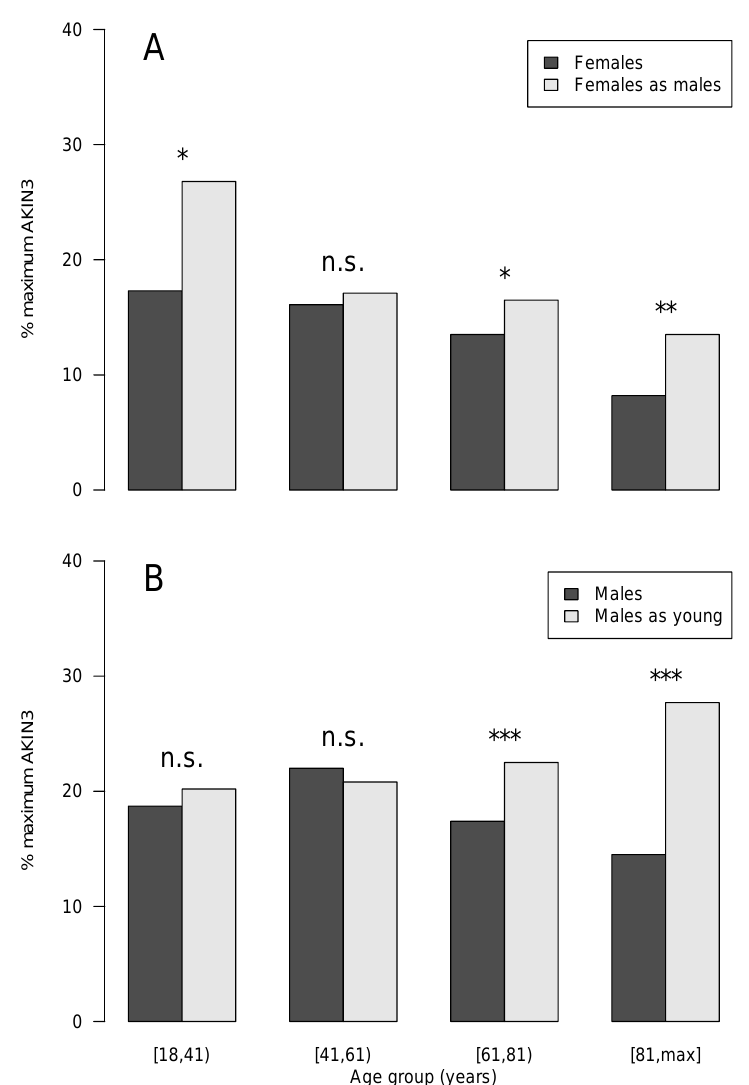
Figure 2. Proportion of AKI cases reaching AKIN3 during hospitalization per age group. Panel ( A ) compares females to the recalculation cohort females-as-males. Proportions decline with age group but are consistently higher in the recalculated cohort. Panel ( B ) compares males to the recalculation cohort males-as-young. Differences in proportions increase with age ( p - value n.s. ≥ 0.05, * <0.05, ** <0.01, and *** <0.001).